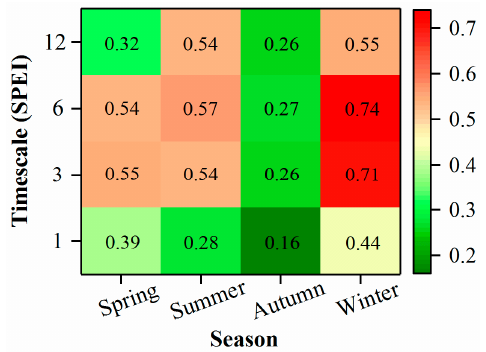
Figure 12. Seasonal characteristics of the correlations between the lake level at Xingzi station and the SPEI values at different timescales.